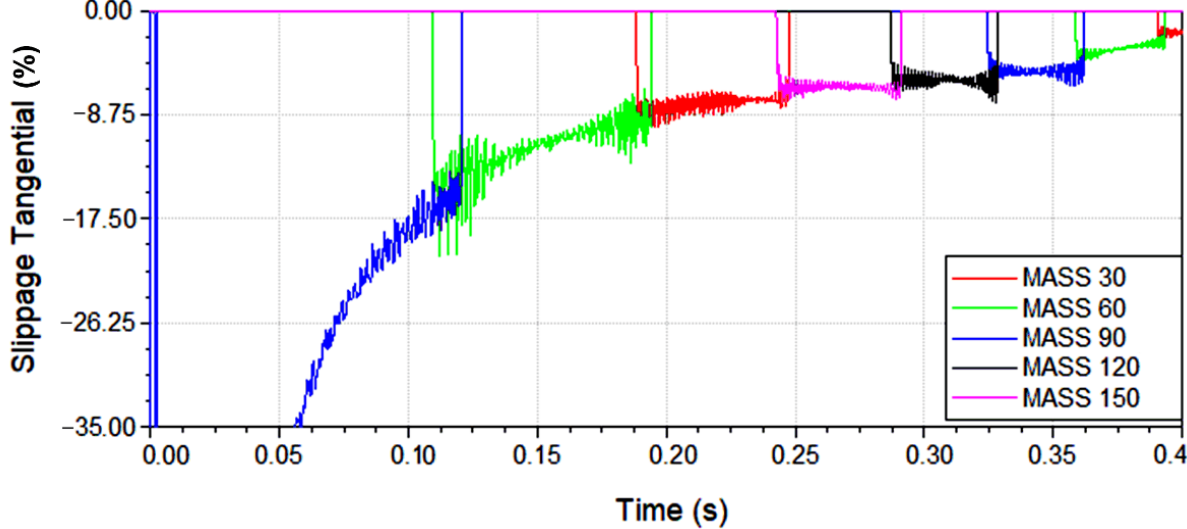
Figure 15. Illustration of belt mass element tangential slippage at ICE crankshaft side [10].